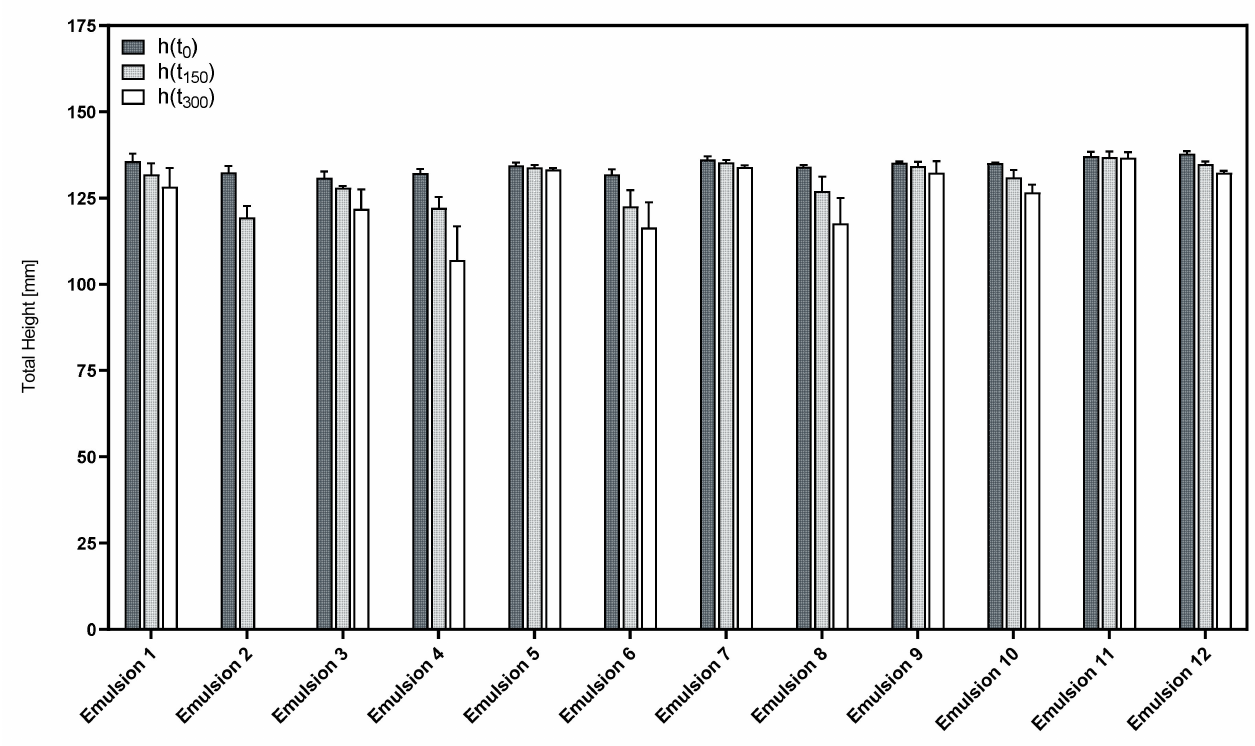
Figure 7. Time course of the total foam height of the phospholipid emulsions; mean ± SD, n =